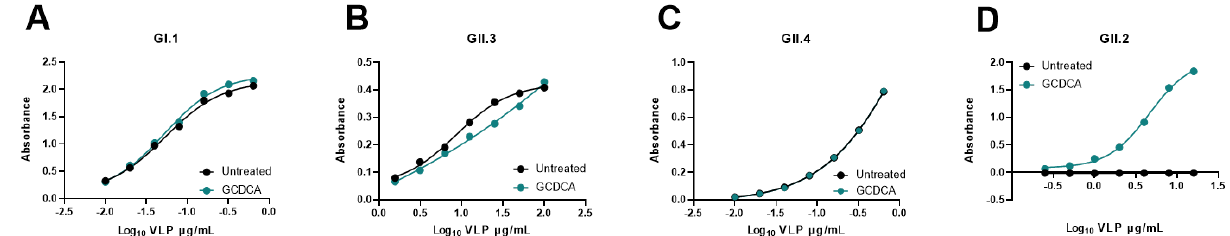
Figure 7. GCDCA enhances GII.2 VLP but not GI.1, GII.3, and GII.4 VLP binding to PGM. ( A – D ) VLPs were tested for their ability to bind to PGM (source of HBGAs) by ELISA in the presence or absence of 500 µ M GCDCA. VLPs used are described in Table 1. Previously unpublished data ( A , C , D ). Derived from Murakami et al., 2020 ( B ) [1]. The PGM binding assays performed are described in Murakami et al., 2020 [1].